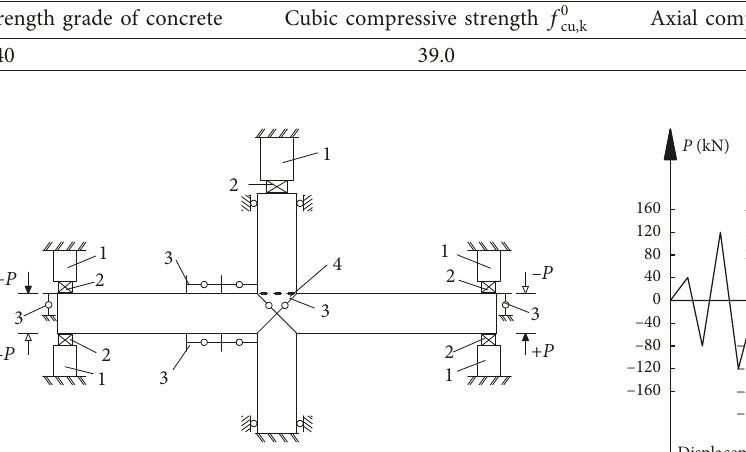
Figure 3: Low-cycle reversed loading device. (1) Jack, (2) load transducer, (3) displacement transducer, and (4) strain gauges.